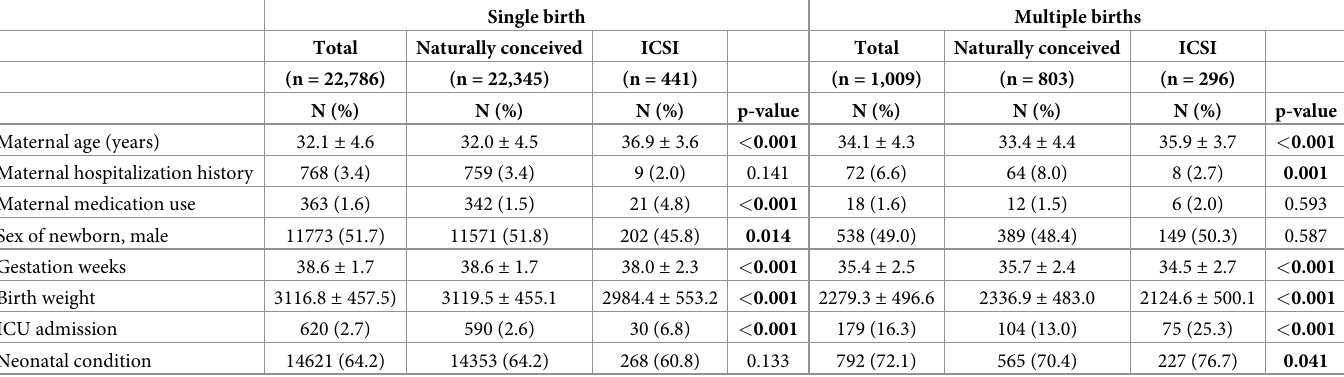
Table 2. Characteristics of pregnant women and newborns for patients with single and multiple births.